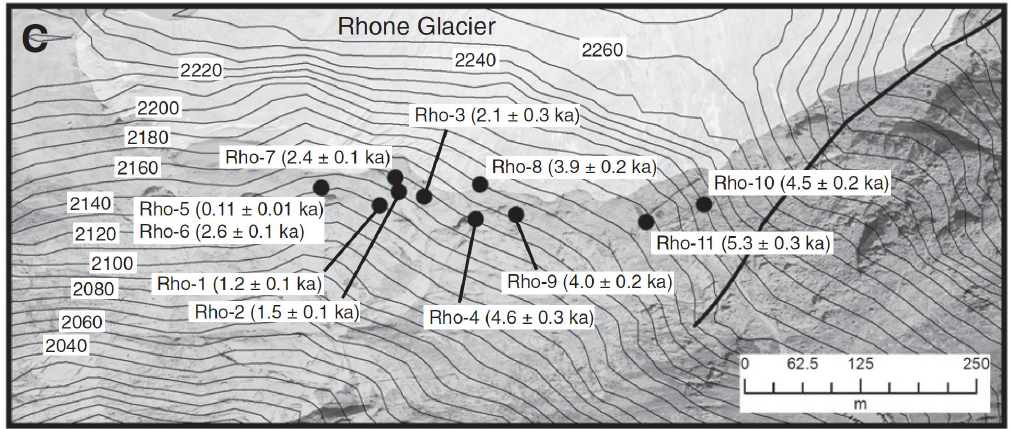
Figure 3 . Sampling location on exposed rocks (darker grey-shaded area) in front of the Rhone Glacier terminus (lighter grey-shaded area). Contour lines are labelled in meters a.s.l. The minimum 10 Be exposure ages are shown. The figure is adopted from the work of Goehring et al . [17].